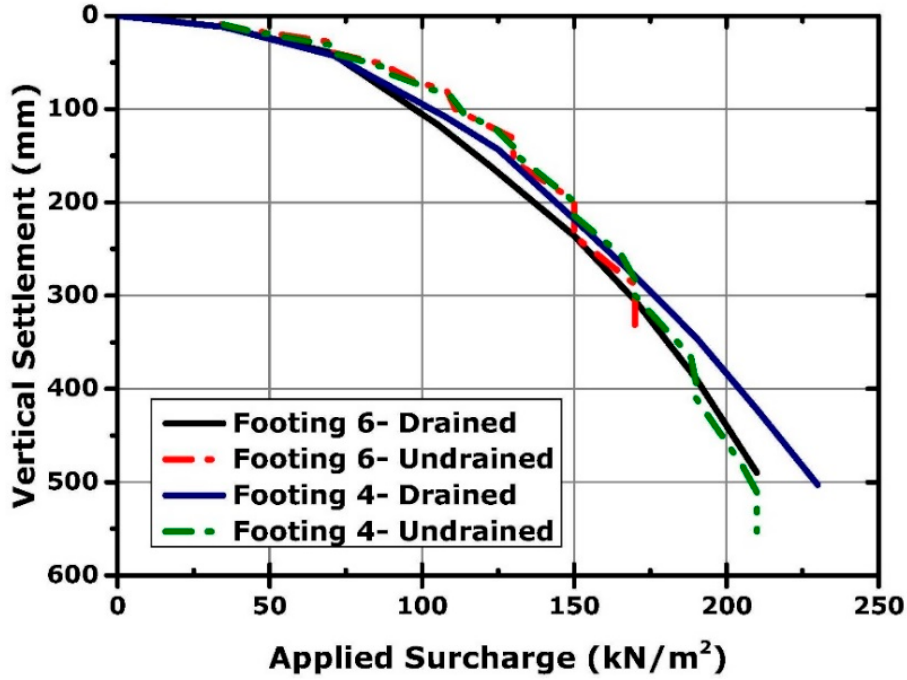
Figure 13. Load-displacement responses for Footings 4 and 6.